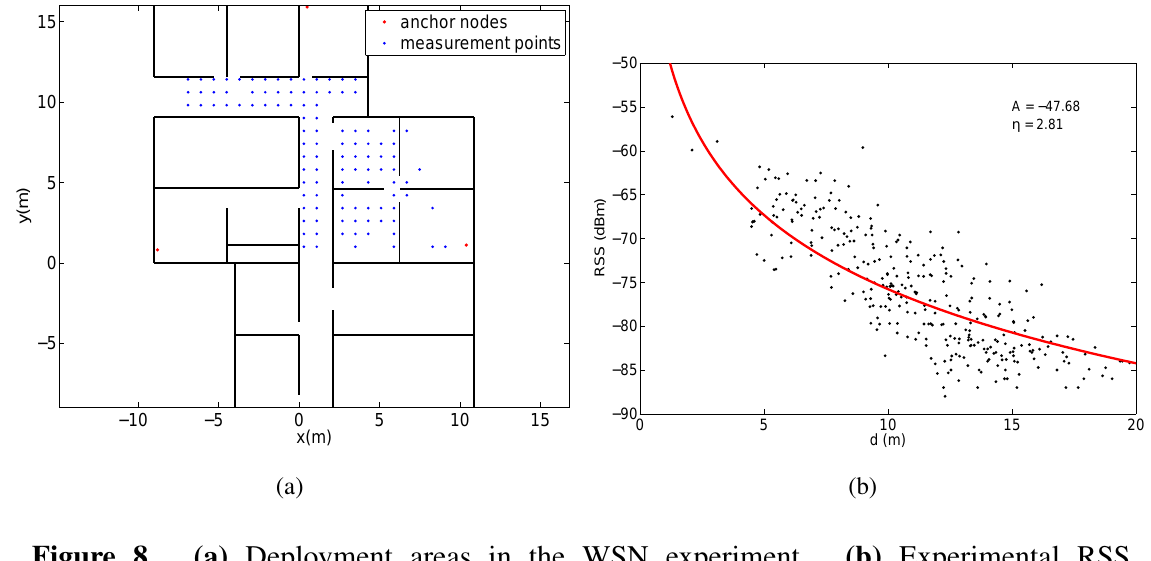
Figure 8. (a) Deployment areas in the WSN experiment. (b) Experimental RSS measurements (2795 values) for different distances between the mobile node and the anchor nodes. The lognormal channel model curve fitting is also